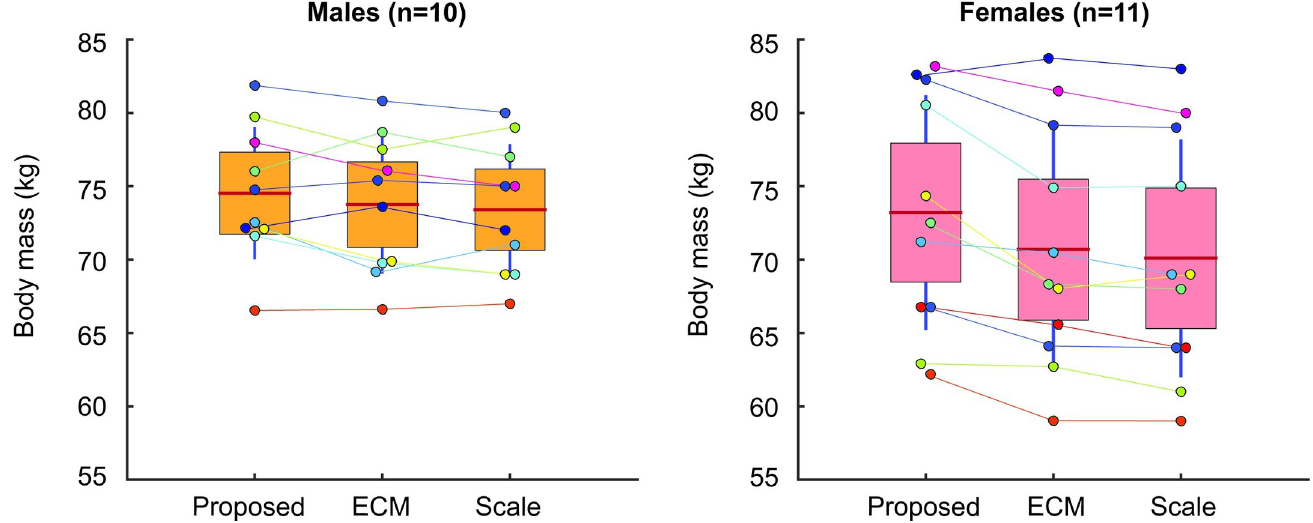
Fig 6. Body mass (kg) estimated with our proposed 3D method, the ECM method, and the medical scale for both males and females. Each participant (coloured dot). The box is the 95% confidence interval around the mean (red line) and SD about the mean is shown (vertical blue line).